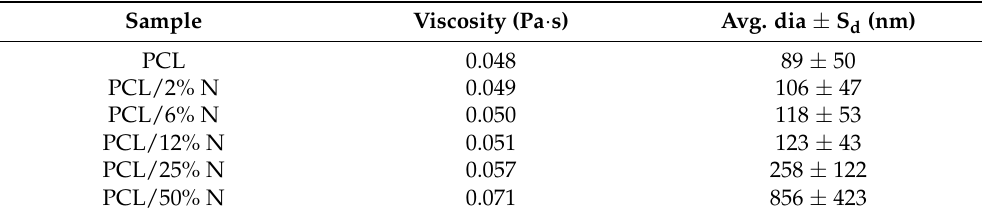
Table 2. The values of the viscosity of solutions, average diameters (avg. dia.) of the tested electrospun fibers PCL and PCL/N electrospun membranes, and standard deviation (S d ) of five replicates. Sample Viscosity (Pa · s) Avg. dia ± S d (nm) PCL 0.048 89 ± 50 PCL/2% N 0.049 106 ± 47